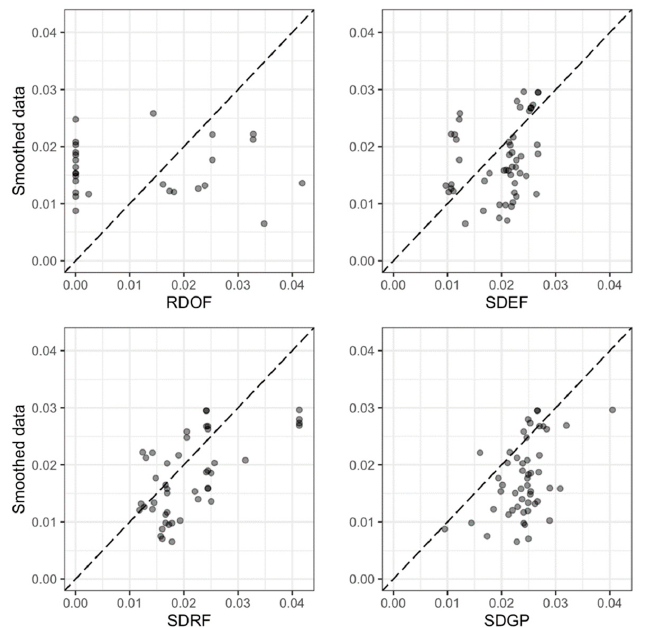
Figure 3. Predicted values for a random out-of-the-bag dataset using the optimal tuned parameters of each model versus observed values of bed load.